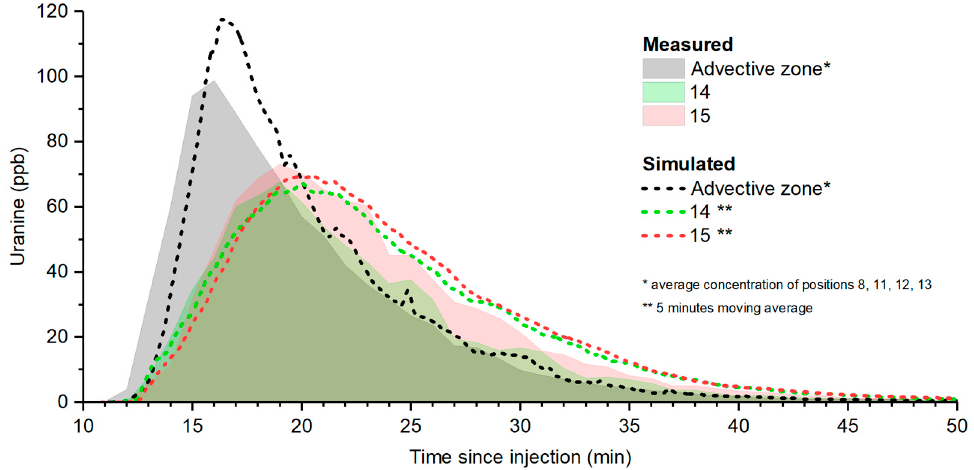
Figure 7. CFD vs. on-site breakthrough curves at cross-section 1.